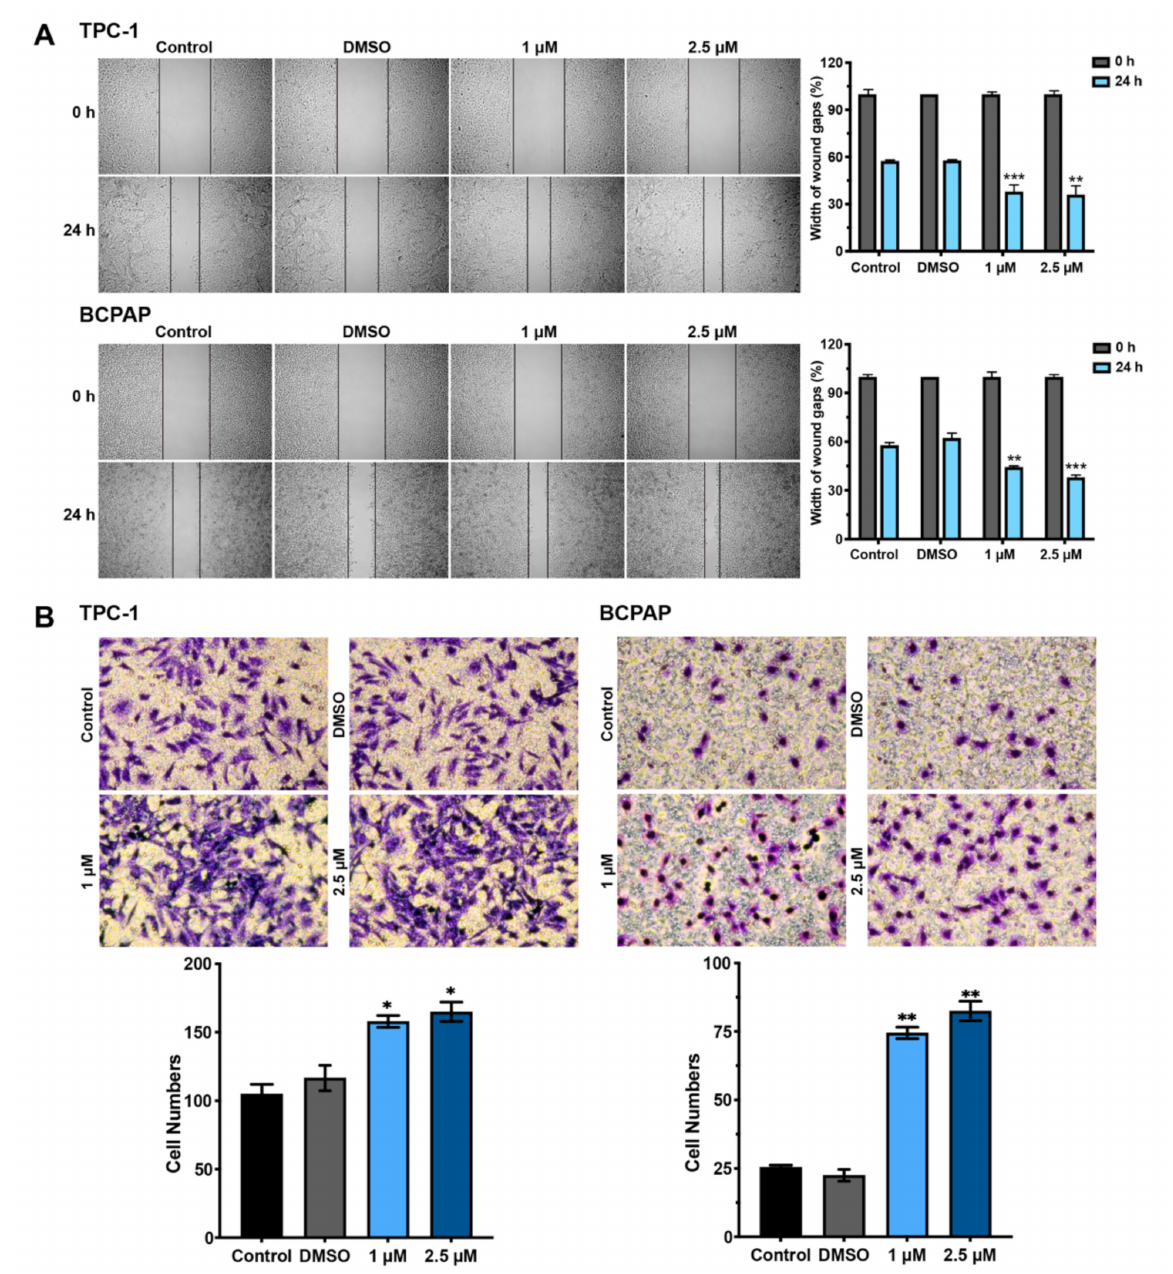
Figure 3. Hormesis effect of BDE209 on Nthy-ori 3-1 and PTC cell invasion and migration. ( A ) Wound- healing assay was performed to assess the mobility of TPC-1 and BCPAP cells treated with different concentrations of BDE209 compared with the negative controls. Representative images are shown on the left, and the statistical analysis is shown on the right. ( B ) The effects of RUVBL1 on cell migration. TPC-1 and BCPAP cell lines were treated as indicated and evaluated by Transwell migration assays. Top panel: Representative images of cell migration. Bottom panel: Quantitative results of the migration assays. * p < 0.05, ** p < 0.01, and *** p < 0.001, based on Student’s t-test. Each experiment was repeated at least three